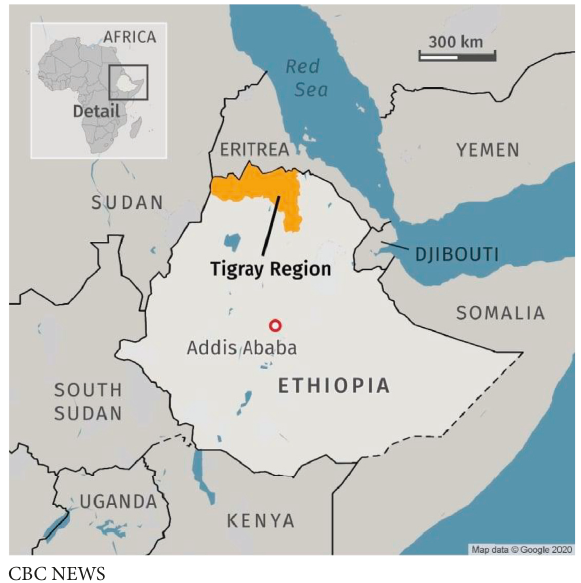
Figure 1: The area of conflict in Tigray region, Northern Ethiopia. Google Maps